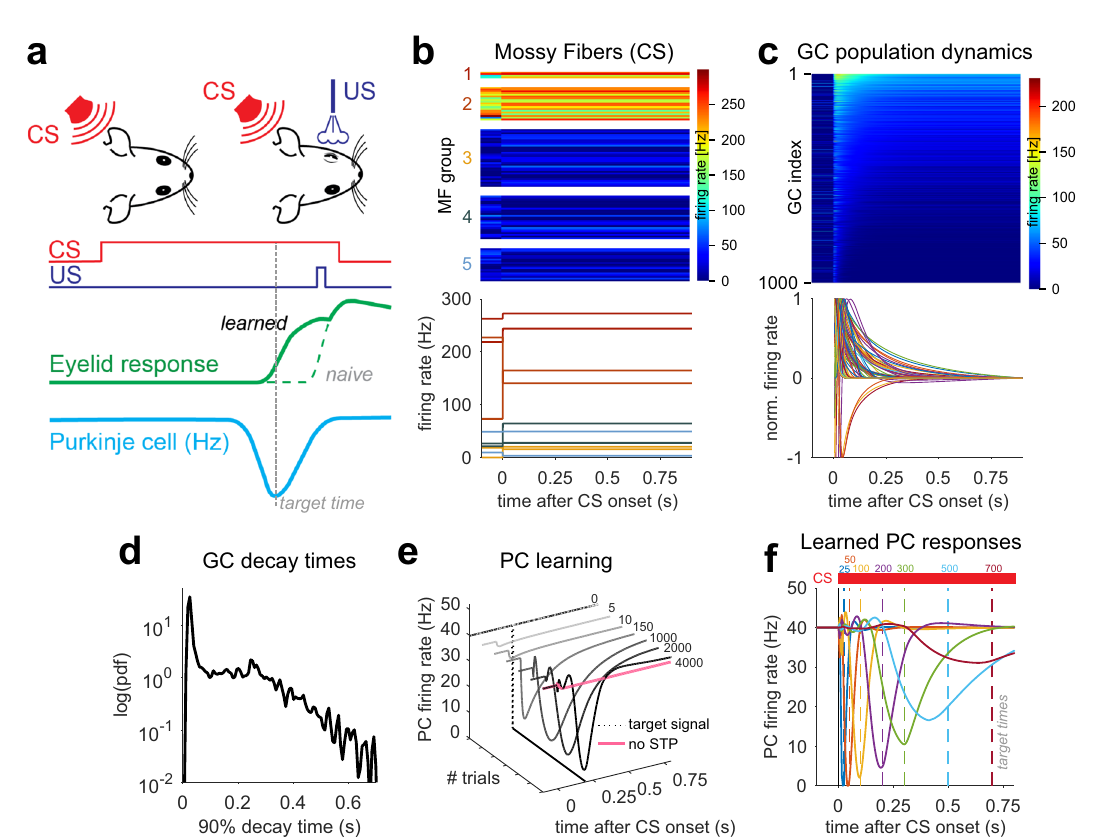
Fig.2 |SimulatingPurkinjecellpausesduringeyelidconditioning.a Schemeof eyelid conditioning. CS: conditioned stimulus (red). US: unconditioned stimulus (violet). After experiencing CS and US pairings at a fi xed temporal interval over many trials, the animal learns to close its eyelid just before the US is delivered (green).A pause in PCactivity (blue) precedes the eyelid closure (target time, gray dashedline). b TheCSismodeledasaninstantaneouschangeinMF fi ringrate.Top: plot of fi ring ratesof 100 MFs, sortedaccording to synaptictypes (MF groups).MF fi ring rates are color-coded and drawn according to the distributions shown in Fig.1b.Bottom:twosampleMFratespersynapticgroup.ColorsasinFig.1. c Model